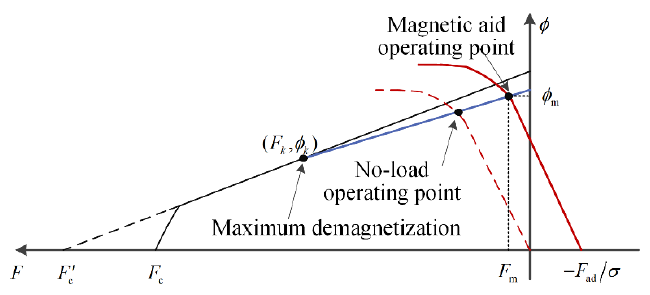
Figure 8. Diagram of PM under no-load and magnetic aid operating points.